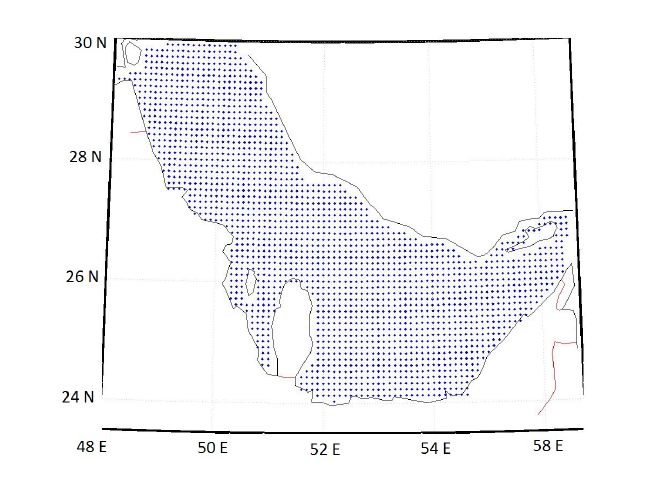
Fig. 1. Distribution of points used for computations